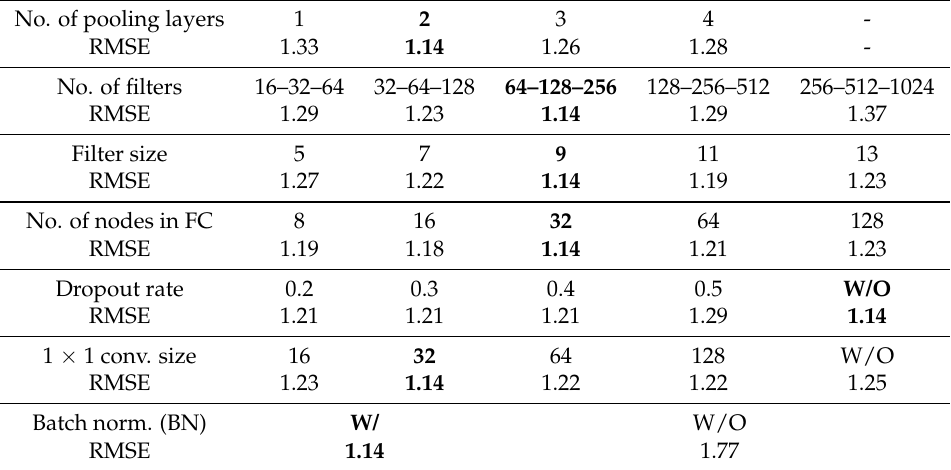
Table 3. Optimization results of deep learning parameters. RMSE: root mean square error.